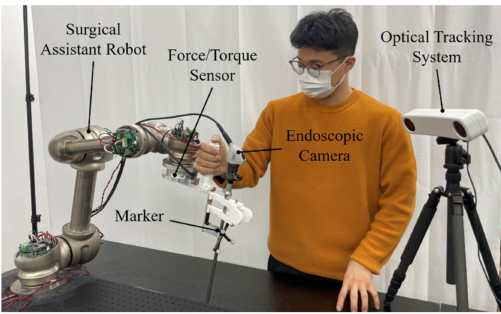
Figure 7. Experiments with a prototype of a surgical assistant robot.